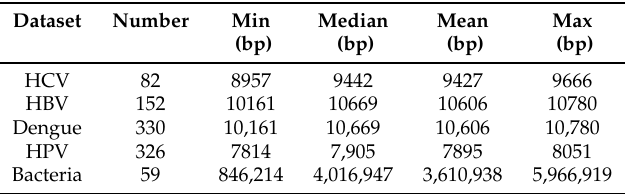
Table 3. Summary of the datasets HCV, HBV, Dengue, HPV, and Bacteria. The length distribution of each dataset validates that PCNV can work with long